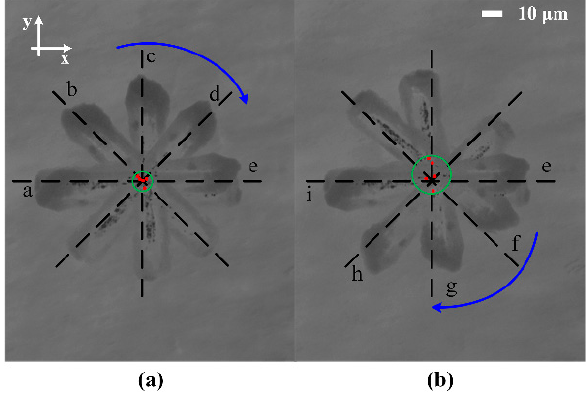
Figure 9. Rotation from 180° to 0° ( a ) and 0° to − 180° ( b ).